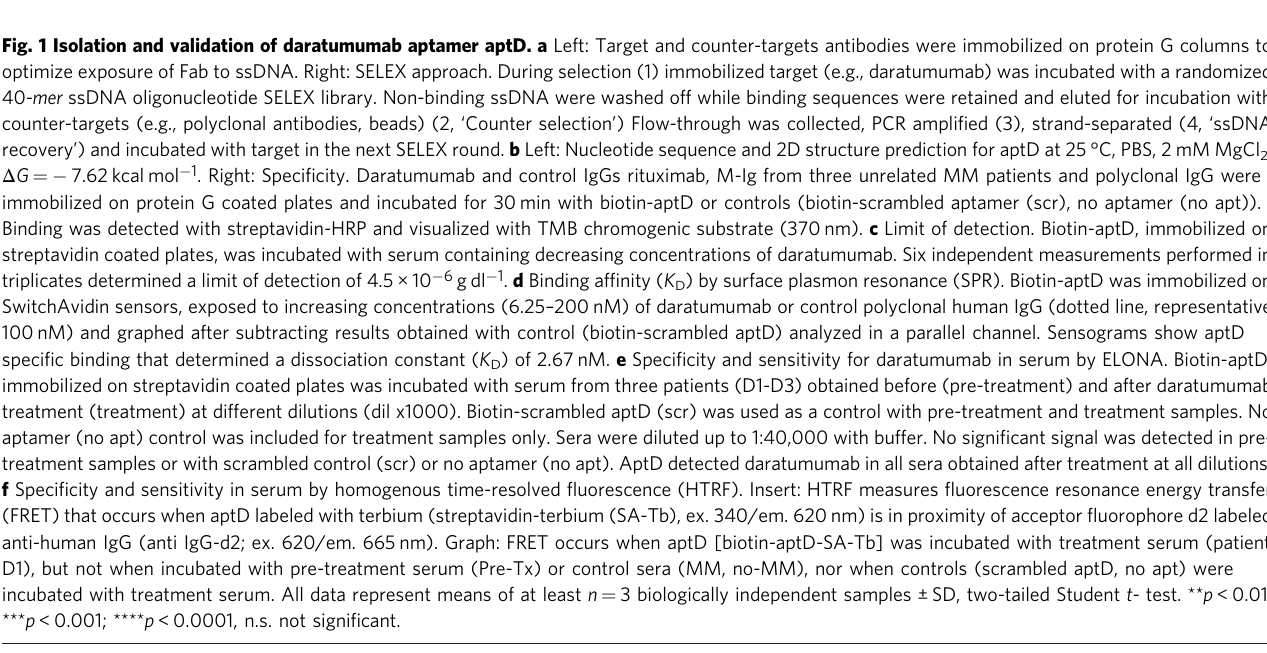
Fig. 1 Isolation and validation of daratumumab aptamer aptD. a Left: Target and counter-targets antibodies were immobilized on protein G columns to optimize exposure of Fab to ssDNA. Right: SELEX approach. During selection (1) immobilized target (e.g., daratumumab) was incubated with a randomized 40- mer ssDNA oligonucleotide SELEX library. Non-binding ssDNA were washed off while binding sequences were retained and eluted for incubation with counter-targets (e.g., polyclonal antibodies, beads) (2, ‘ Counter selection ’ ) Flow-through was collected, PCR ampli fi ed (3), strand-separated (4, ‘ ssDNA recovery ’ ) and incubated with target in the next SELEX round. b Left: Nucleotide sequence and 2D structure prediction for aptD at 25 °C, PBS, 2 mM MgCl 2 : Δ G = − 7.62 kcal mol − 1 . Right: Speci fi city. Daratumumab and control IgGs rituximab, M-Ig from three unrelated MM patients and polyclonal IgG were immobilized on protein G coated plates and incubated for 30 min with biotin-aptD or controls (biotin-scrambled aptamer (scr), no aptamer (no apt)). Binding was detected with streptavidin-HRP and visualized with TMB chromogenic substrate (370 nm). c Limit of detection. Biotin-aptD, immobilized on streptavidin coated plates, was incubated with serum containing decreasing concentrations of daratumumab. Six independent measurements performed in triplicates determined a limit of detection of 4.5 × 10 − 6 g dl − 1 . d Binding af fi nity ( K D ) by surface plasmon resonance (SPR). Biotin-aptD was immobilized on SwitchAvidin sensors, exposed to increasing concentrations (6.25 – 200 nM) of daratumumab or control polyclonal human IgG (dotted line, representative 100 nM) and graphed after subtracting results obtained with control (biotin-scrambled aptD) analyzed in a parallel channel. Sensograms show aptD speci fi c binding that determined a dissociation constant ( K D ) of 2.67 nM. e Speci fi city and sensitivity for daratumumab in serum by ELONA. Biotin-aptD, immobilized on streptavidin coated plates was incubated with serum from three patients (D1-D3) obtained before (pre-treatment) and after daratumumab treatment (treatment) at different dilutions (dil x1000). Biotin-scrambled aptD (scr) was used as a control with pre-treatment and treatment samples. No aptamer (no apt) control was included for treatment samples only. Sera were diluted up to 1:40,000 with buffer. No signi fi cant signal was detected in pre- treatment samples or with scrambled control (scr) or no aptamer (no apt). AptD detected daratumumab in all sera obtained after treatment at all dilutions. f Speci fi city and sensitivity in serum by homogenous time-resolved fl uorescence (HTRF). Insert: HTRF measures fl uorescence resonance energy transfer (FRET) that occurs when aptD labeled with terbium (streptavidin-terbium (SA-Tb), ex. 340/em. 620 nm) is in proximity of acceptor fl uorophore d2 labeled anti-human IgG (anti IgG-d2; ex. 620/em. 665 nm). Graph: FRET occurs when aptD [biotin-aptD-SA-Tb] was incubated with treatment serum (patient D1), but not when incubated with pre-treatment serum (Pre-Tx) or control sera (MM, no-MM), nor when controls (scrambled aptD, no apt) were incubated with treatment serum. All data represent means of at least n = 3 biologically independent samples ± SD, two-tailed Student t - test. ** p < 0.01; *** p < 0.001; **** p < 0.0001, n.s. not signi fi